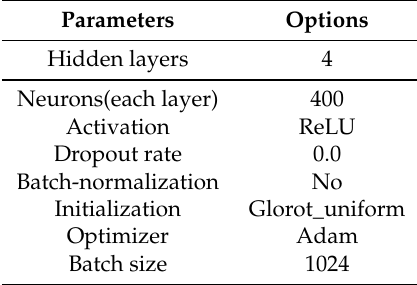
Table 2. The selected model after the random